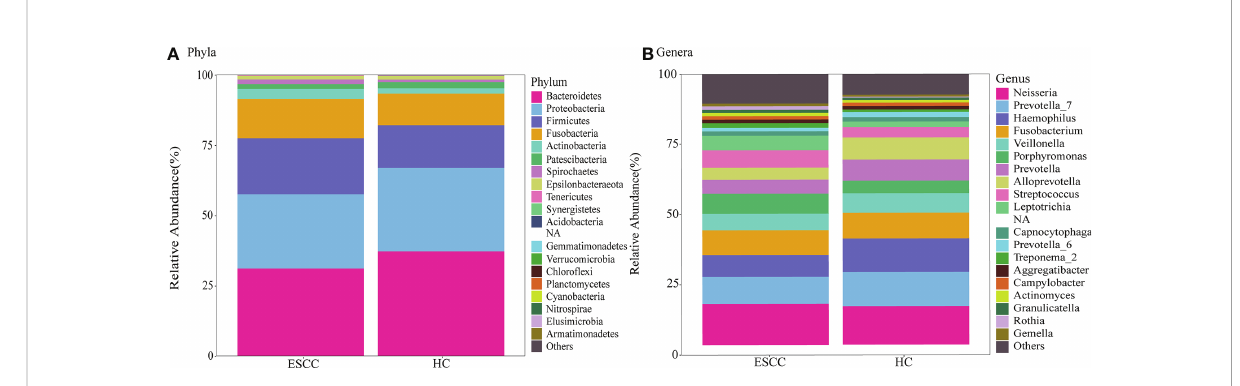
FIGURE 3 Taxonomic composition of saliva microbiota of ESCC patients and healthy controls. Relative abundance bar plots show the relative abundance of bacterial (A) phyla and (B) genera in each sample.